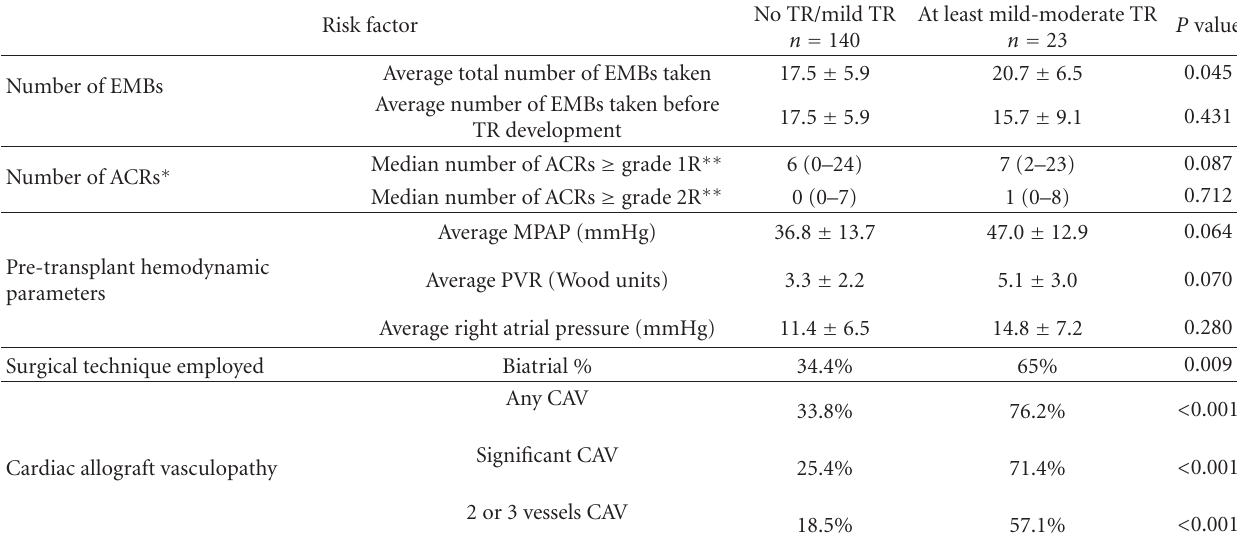
Table 3: A univariate analysis of risk factors for late significant (at least mild-moderate)